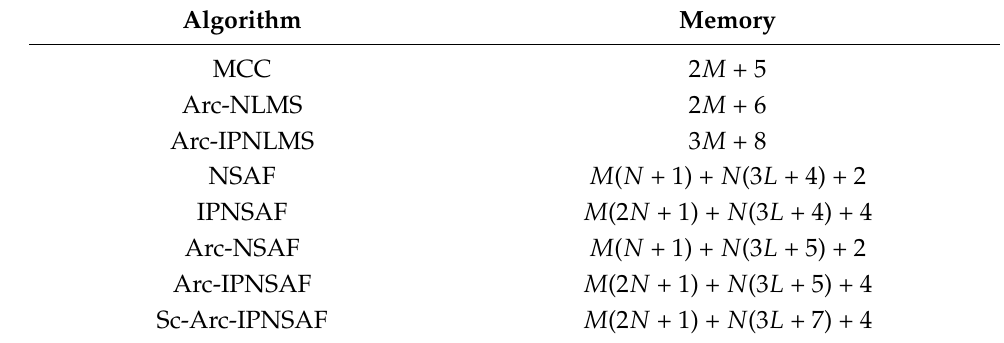
Table 2. Memory requirements for each